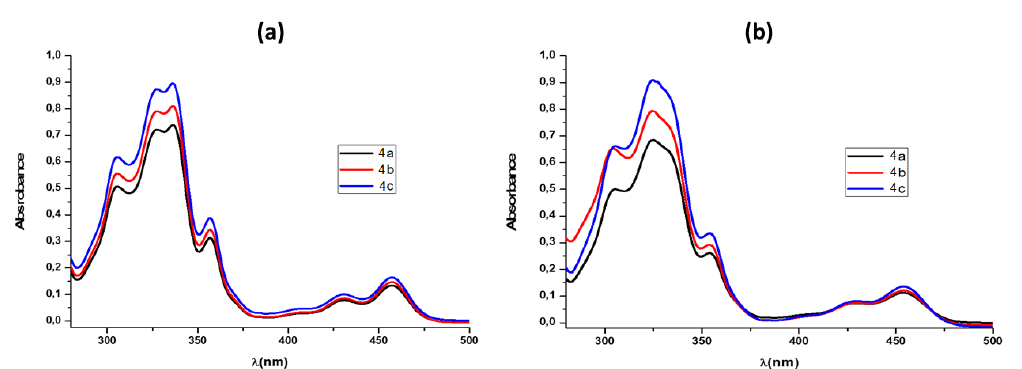
Figure 2. UV–Vis spectra of photocyclized salts 4a – c ( a ) in chloroform ( ca. 8 × 10 − 4 M) and ( b ) in methanol ( ca. 8 × 10 − 4 M). Unlike salts 3 , the rigid polycyclic scaffold of 4a – c prevented non-radiative decay processes of their excited species, leading to an emission band around 480 nm (Figure 3).